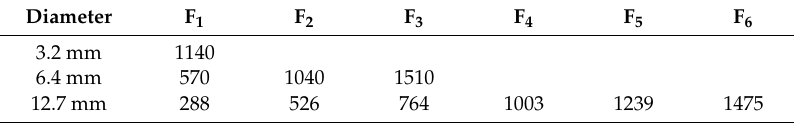
Table 2. Values of the frequencies, F x , for amplitude minima, f min (in kHz).